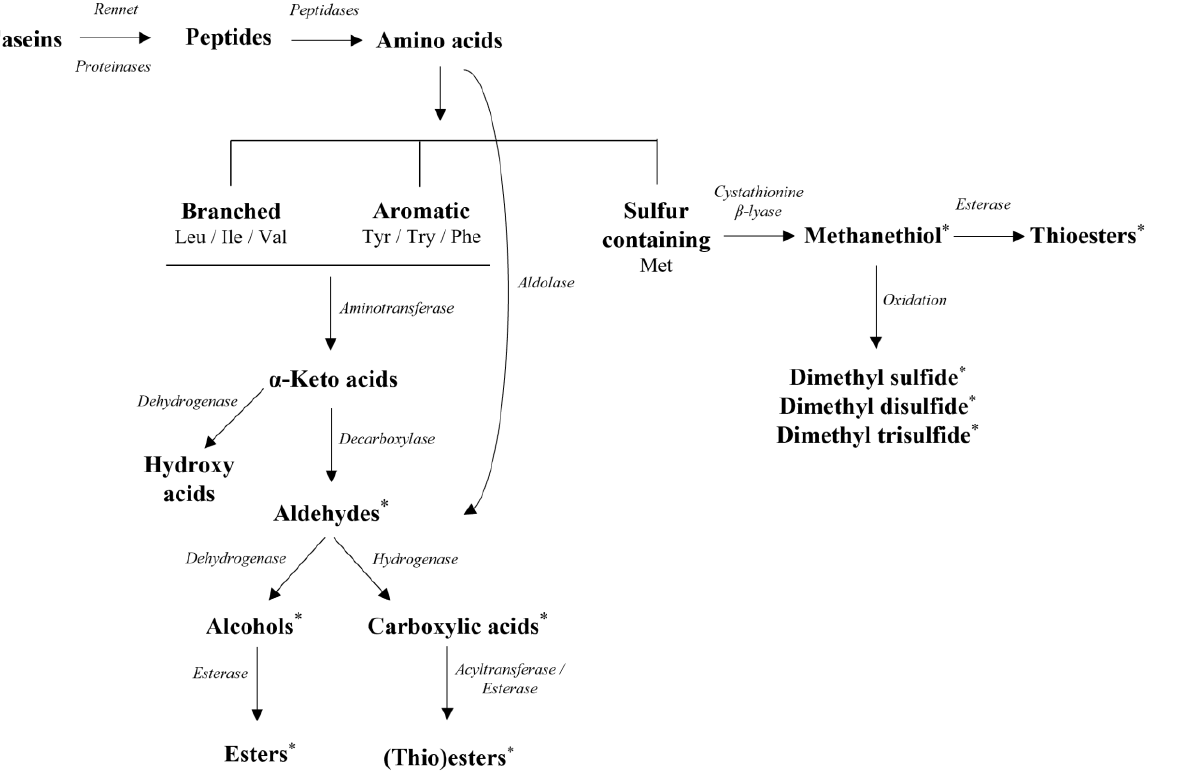
Figure 5. Schematic representation of amino acid catabolism pathways involved in the development of cheese flavor. Asterisks denotes potent flavor compounds [6,103].